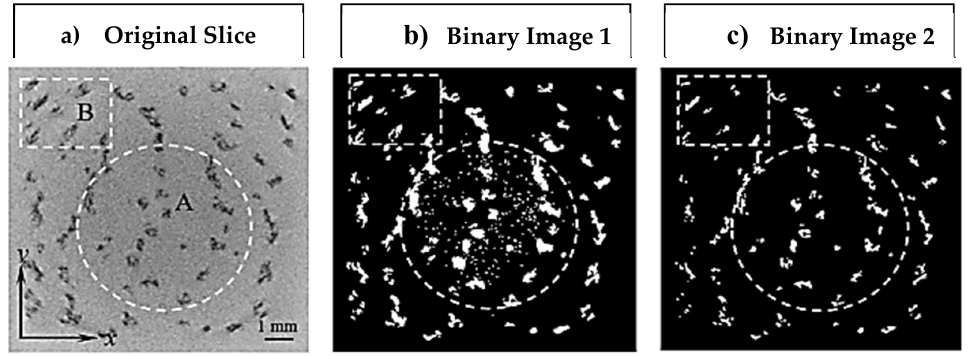
Figure 10. Original slice and binary images [21].